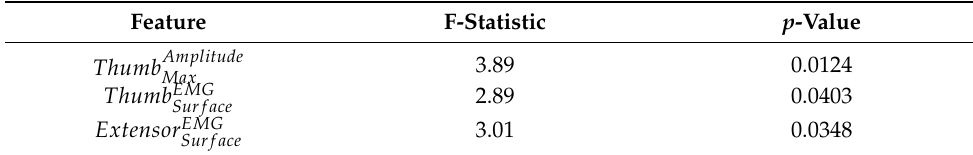
Figure 9. EEG correlation illustrated by band-wave, sensor, region and feature. Table 9. Repeated ANOVA tests over selected EMG features.